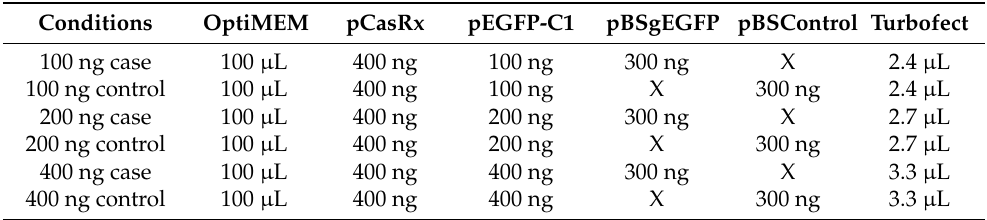
Table 2. Composition of the plasmid DNA mixtures OptiMEM and Turbofect which were transfected per well of U-2 OS